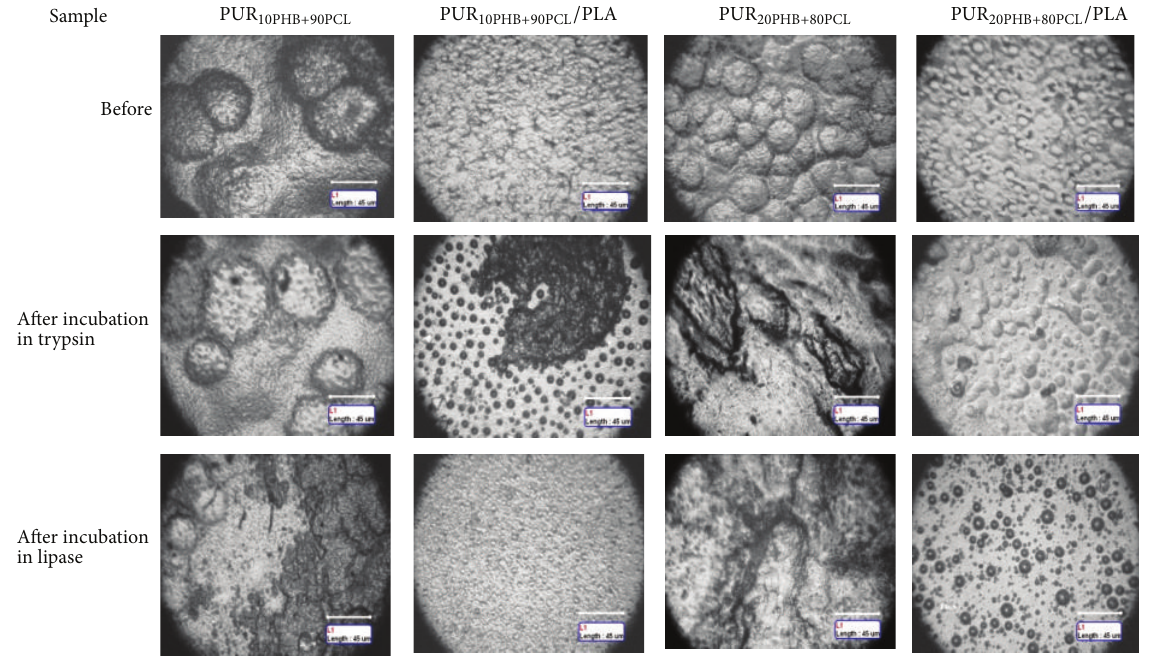
and their blends with poly([D,L]-lactide) could be useful for long-term degradative material for tissue